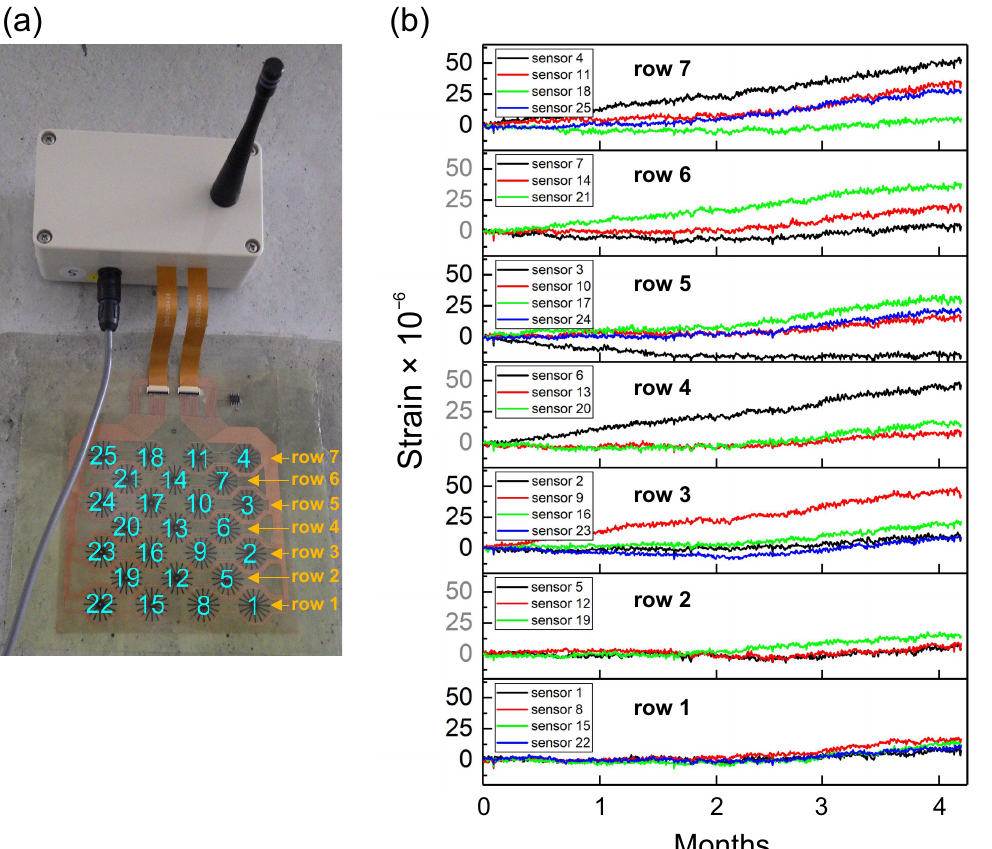
Figure 3. ( a ) Sensor array with the connected wireless transmitter installed on a surface with no crack. The numbers correspond to specific sensors in the array. To make it easier to distinguish data between all 25 sensors, the results were analyzed with respect to the rows in the array. ( b ) Four-month-long static strain measurement to assess the long-term stability of the sensors.